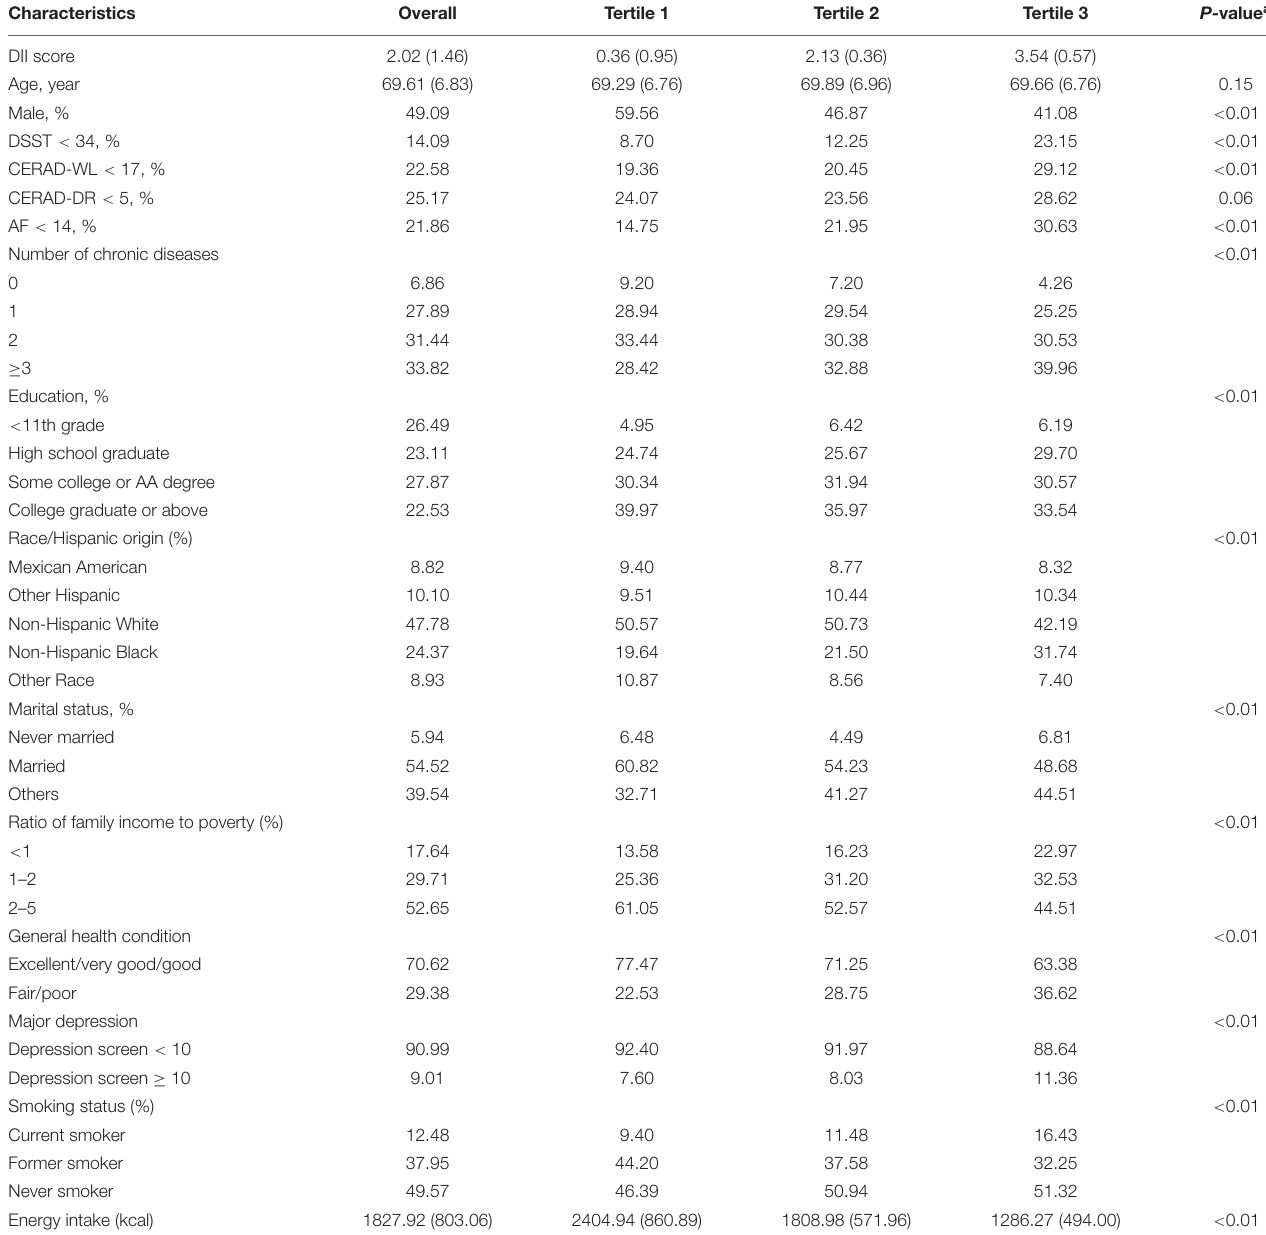
TABLE 1 | Population characteristics by dietary inflammatory index scores. Characteristics Overall Tertile